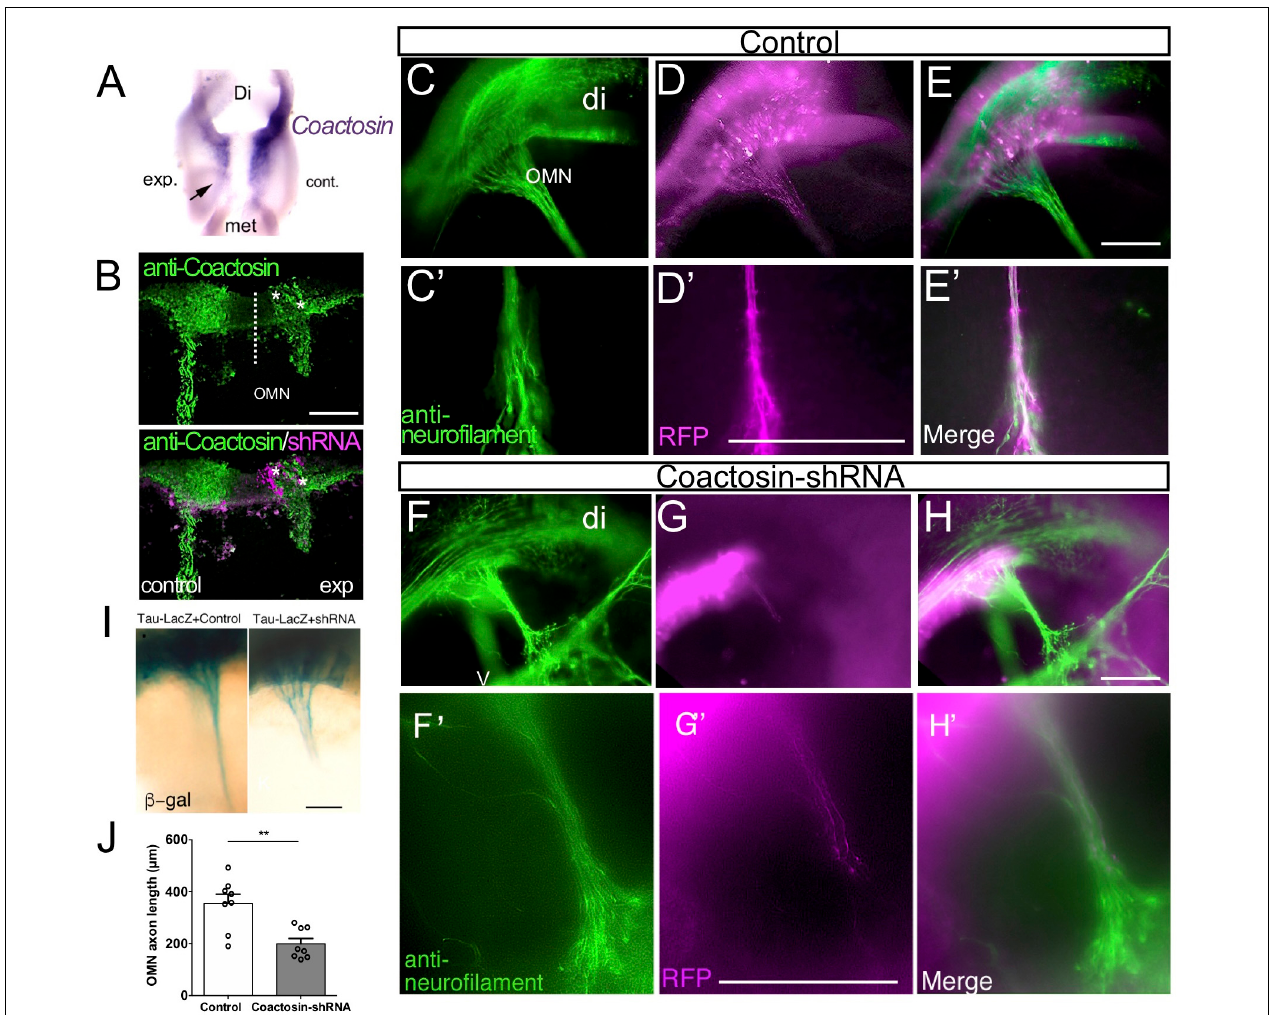
FIGURE 2 | Effects of coactosin knockdown on elongation of the oculomotor nerve. (A) Reduction in coactosin mRNA levels following transfection with coactosin short hairpin RNA (shRNA). Ventral view of the midbrain showing the weak expression on the experimental side (exp) compared with that in the control side (cont). (B) Coactosin ( green ) expression is reduced in the coactosin shRNA-/RFP-expressing oculomotor nucleus (OMN) on the experimental side (asterisks). (C–H) Effects of scrambled (control) shRNA (C–E) or coactosin shRNA ( F–H ) transfection on the oculomotor nerve. Double staining of RFP and neurofilament ( green ) shows the control shRNA-transfected axons extending toward an eye ( C (cid:48) –E (cid:48) : higher magnification of C–E ). In contrast, coactosin shRNA transfection disrupted the elongation of the oculomotor nerve ( F (cid:48) –H (cid:48) : higher magnification of F–H ). (I) Effects of control shRNA (left) or coactosin shRNA (right) transfection on the tau-LacZ-expressing oculomotor nerve. The tau-lacZ-labeled axons paused at the midway of their migration route following coactosin knockdown. (J) The length of oculomotor axons from its nucleus shows a shrinkage with coactosin shRNA than control shRNA (eight embryos for each, ** p = 0.0047, Mann–Whitney U test). Scale bar: 100 µ